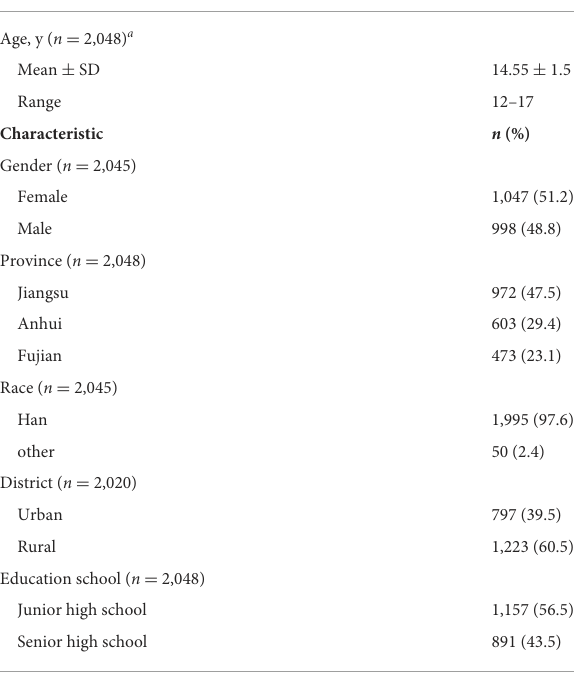
TABLE 1 Participant characteristics ( n =